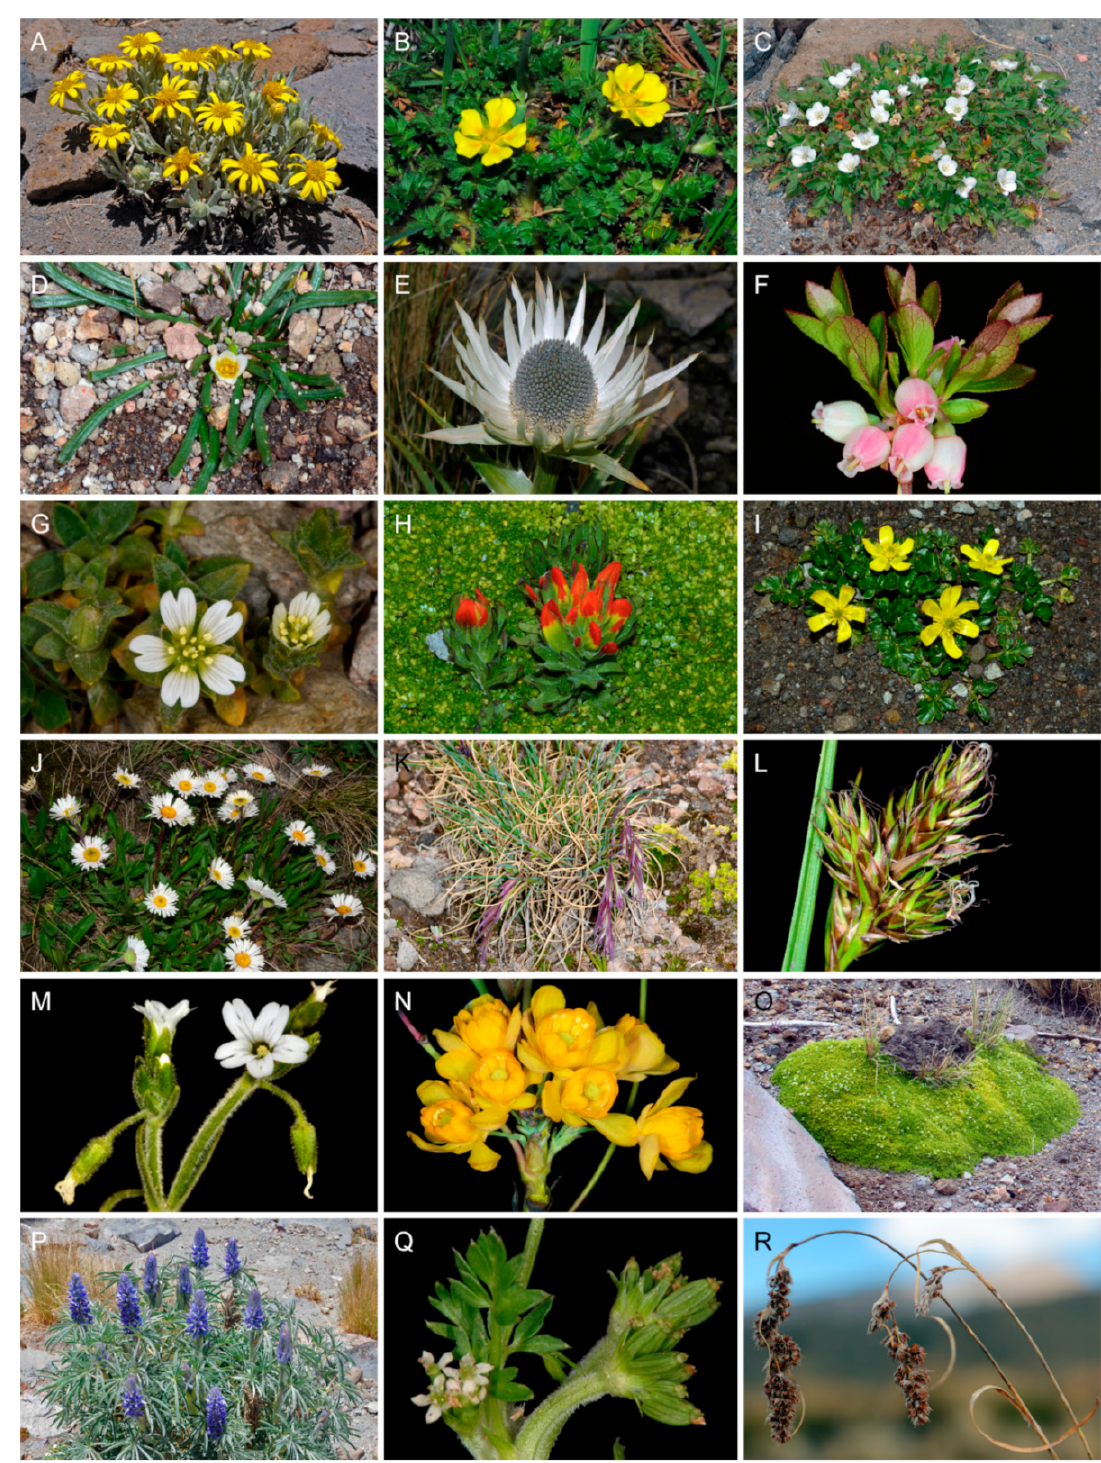
Figure 3. Characteristic plants of the central Mexican alpine flora. ( A ) Senecio procumbens ; ( B ) Potentilla richardii ; ( C ) Phacelia platycarpa ; ( D ) Calandrinia acaulis ; ( E ) Eryngium proteiflorum ; ( F ) Vaccinium cespitosum ; ( G ) Cerastium purpusii ; ( H ) Castilleja tolucensis growing in a cushion of Arenaria bryoides ; ( I ) Ranunculus multicaulis ; ( J ) Erigeron galeottii ; ( K ) Festuca livida ; ( L Carex curviculmis ; ( M ) Cerastium tolucense ; ( N ) Berberis alpina ; ( O ) Arenaria bryoides ; ( P ) Lupinus montanus ; ( Q ) Chaerophyllum tolucanum ; ( R ) Luzula racemosa . Credits: ( A – C , E – N , P , Q ) Victor Steinmann; ( D ) Libertad Arredondo; ( O ) Adolfo L ó pez; ( R ) Harald